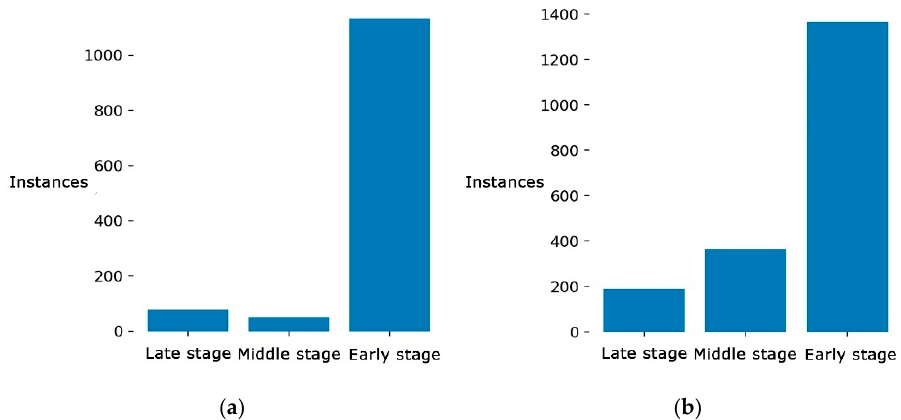
Figure 5. The sample number of various categories: ( a ) KP dataset and ( b ) CP dataset.